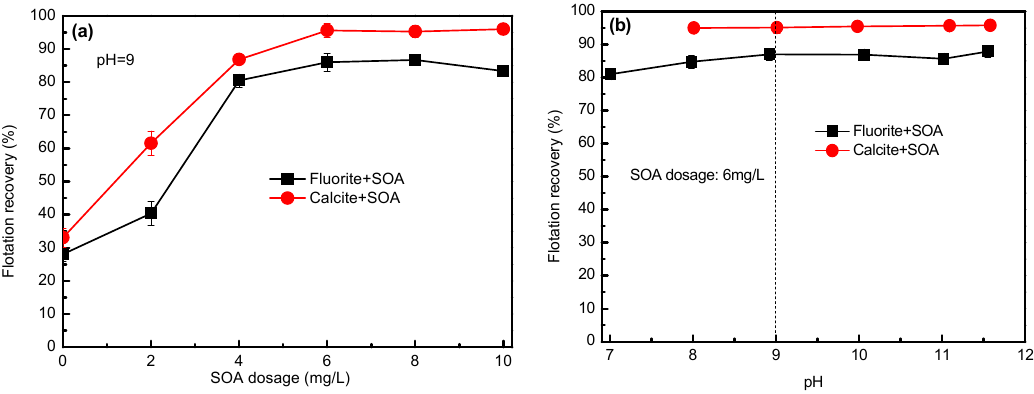
Figure 3. Effect of SOA dosage ( a ) and pH ( b ) on flotation recoveries of calcite and fluorite minerals using SOA as the collector.